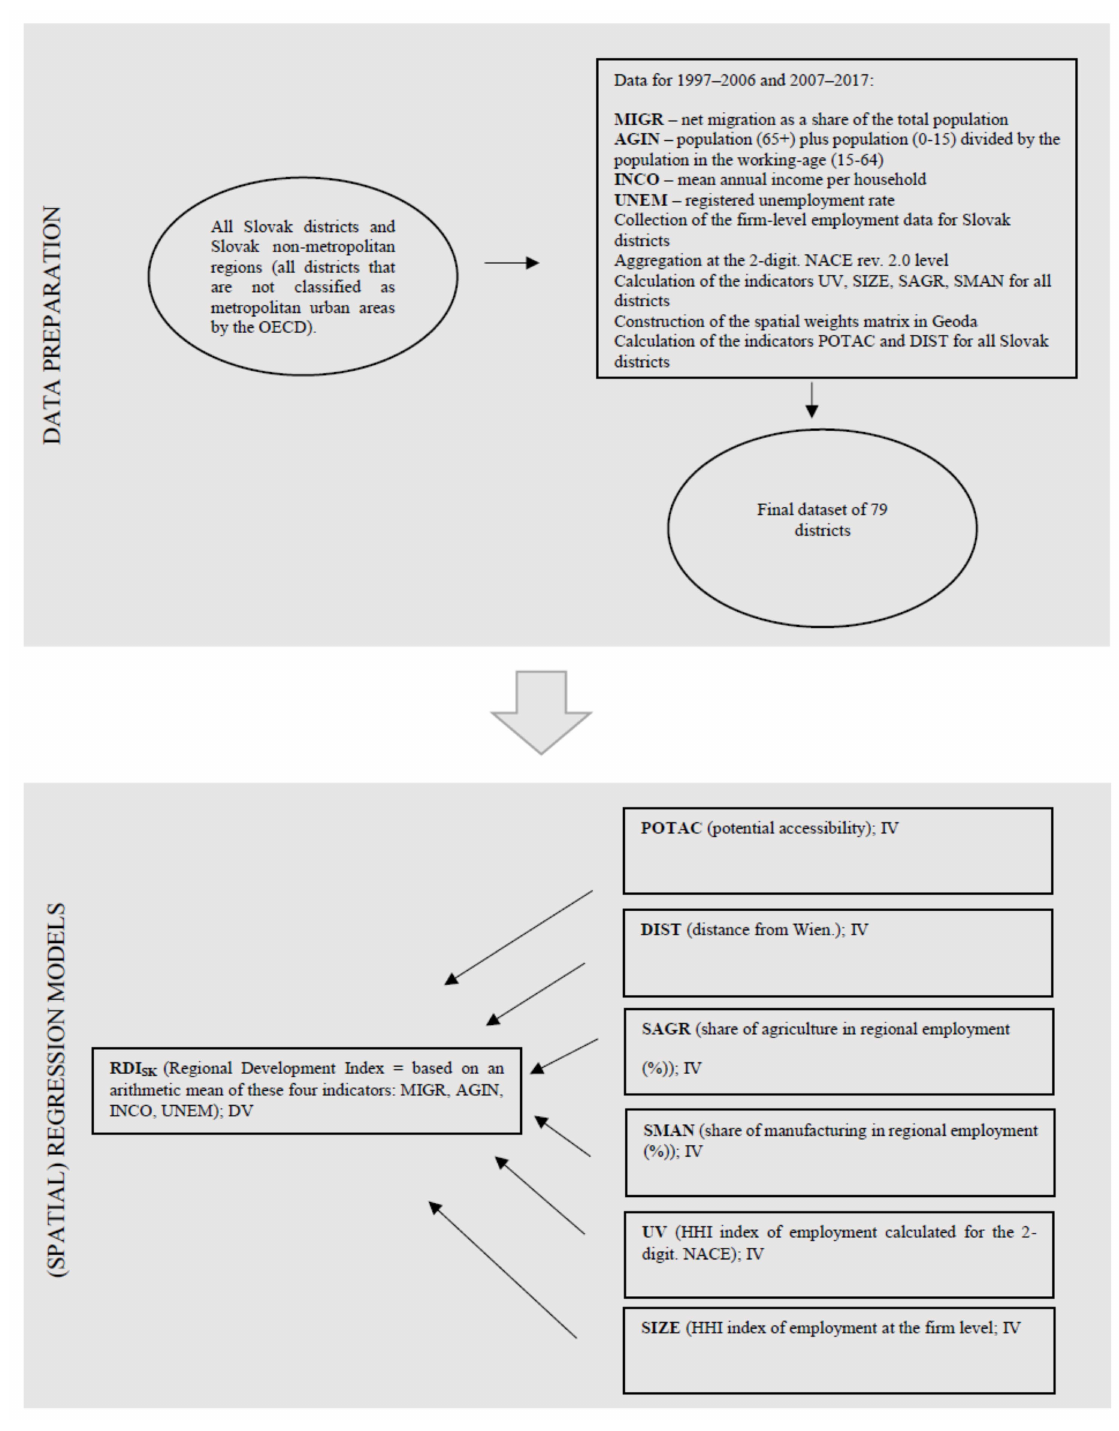
Figure 2. Flow chart: methodology of the paper. Source: the